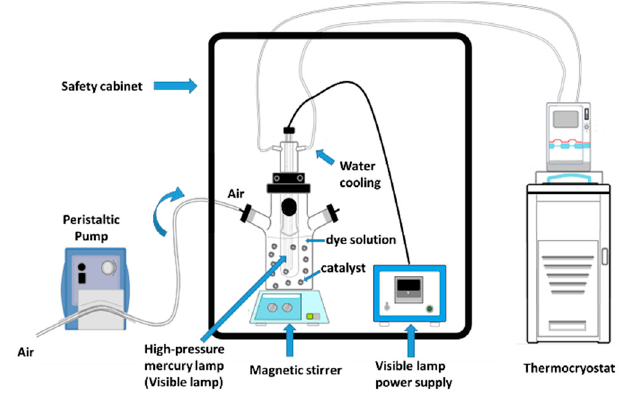
Figure 7. Schematic photocatalytic-reactor set-up.